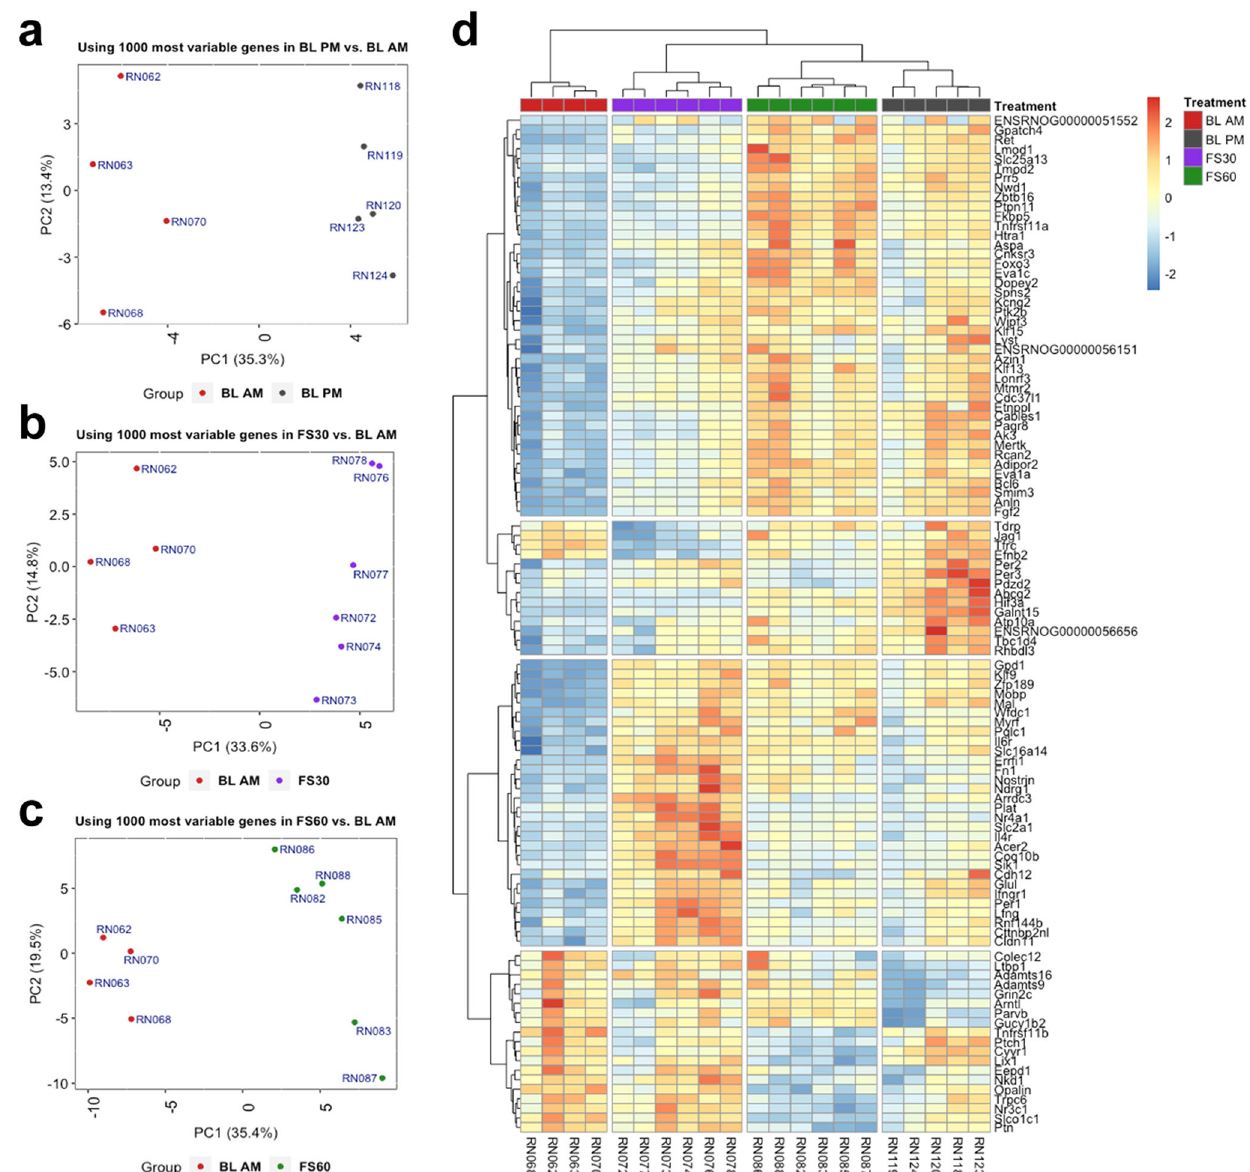
Fig. 3 RNA-Seq data analysis of rat hippocampal samples. Samples were collected under BLAM, 30 or 60 min following forced swimming (FS30 or FS60, respectively), or under BLPM conditions. a-c Principal component analysis (PCA) of the top 1000 most variable genes based on intronic read counts revealed clear separation of experimental groups along the PC1 axis indicating much of the variance (~35%) associated with this eigenvector can be attributed to group for BLPM vs BLAM ( a ), FS30 vs BLAM ( b ) and FS60 vs BLAM ( c ) comparisons. d Heatmap showing centered log-scaled expression values in each sample for the top 104 differentially expressed genes (FDR < 0.05). Top 50 differentially expressed genes were identi fi ed, using intronic count data, in each comparison (FS30, FS60, and BLPM vs. BLAM conditions) and collated to a single list of 104